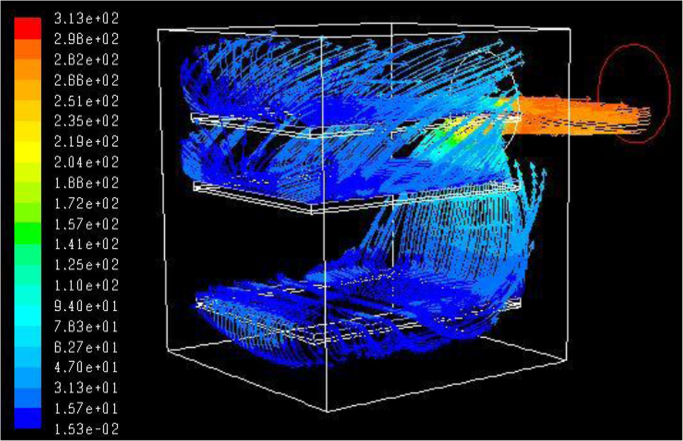
Examples of the streaklines of the vapor flowing out of the large scale chamber (velocity is in m/s): for sake of clarity only the flow coming from the 1st, 8th and 12th of the 14 shelves (corresponding to a distance h equal to 110 mm and an effective clearance r=67 mm, configuration L1) is shown.